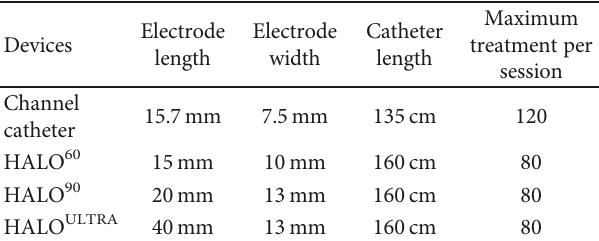
Table 1: Main technical speci fi cations of RFA devices used for treatment of